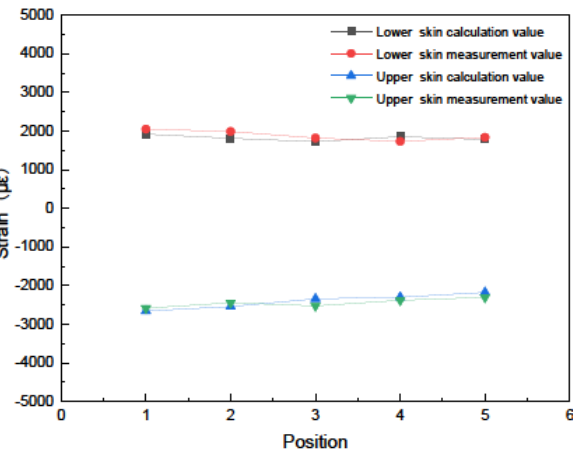
Figure 8: The result of strain measurement and FE analysis